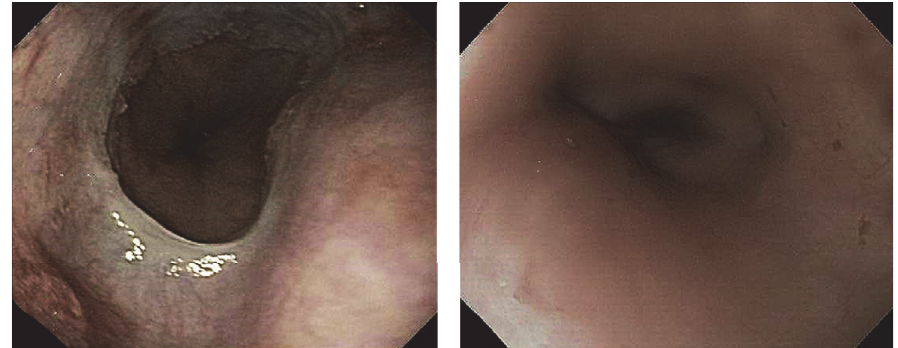
Figure 1: Initial EGDs showed normal esophagus with no evidence of aortoesophageal fistula. No evidence of bleeding in the esophagus.